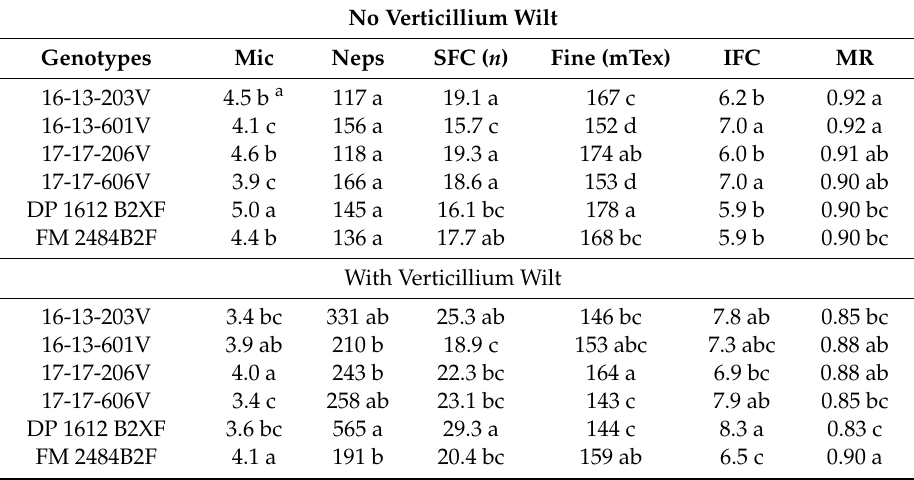
Table 3. Least square means for fiber properties of micronaire, neps, short fiber content by number (SFC (n))), fine(mTex), immature fiber content (IFC), and maturity ratio (MR) with and without Verticillium wilt.